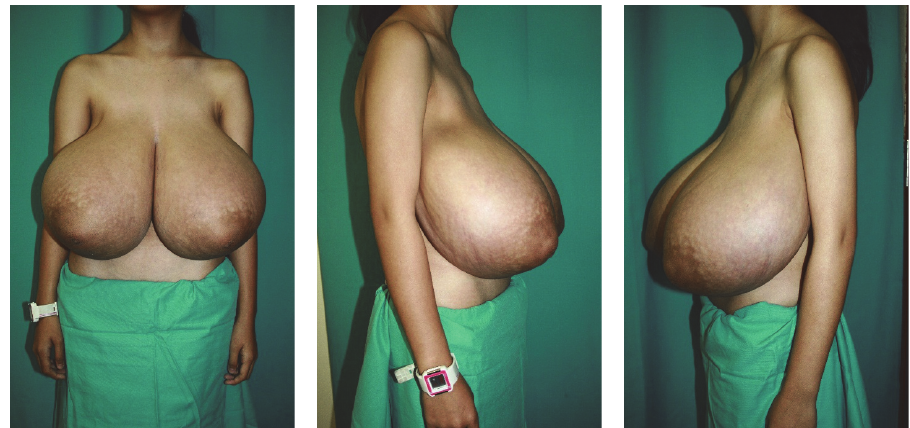
Figure 1: Preoperative anterior and lateral view. The breast measurement was as follows: suprasternal notch-to-nipple distance was 36 cm bilaterally, nipple-to-IMF distance was 26 cm bilaterally, and nipple-to-nipple distance was 21cm.